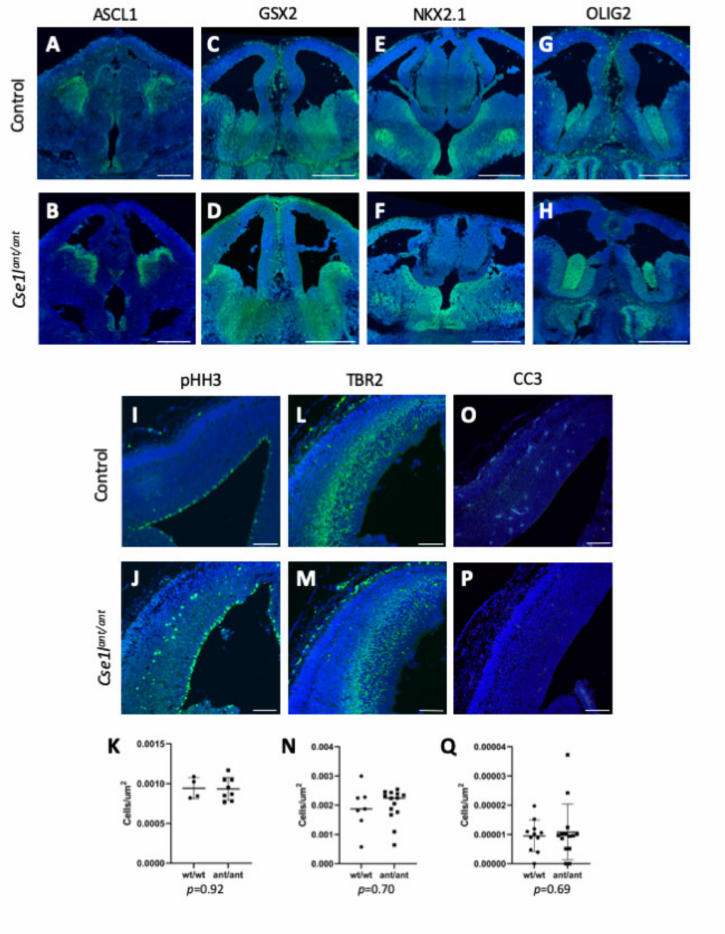
Figure 7. Marker analysis of forebrain shows that patterning is not disrupted perturbed in Cse1l ant/ant mutants. ( A – H ) Patterning markers in the developing forebrain show no difference in regionalization at E14.5 ( I , J ). pHH3 staining shows some mislocalized proliferating cells in mutant cortex. ( L , M ) Mu- tants show a slight decrease in TBR2 staining ( O , P ) and no increase in CC3 staining. Quantification of pHH3 ( K ), TBR2 ( N ) and CC3-apoptosis data ( Q ) ( p values are the result of unpaired t tests). Scale bars are 500 µ m in ( A – H ) and 100 µ m ( I – P